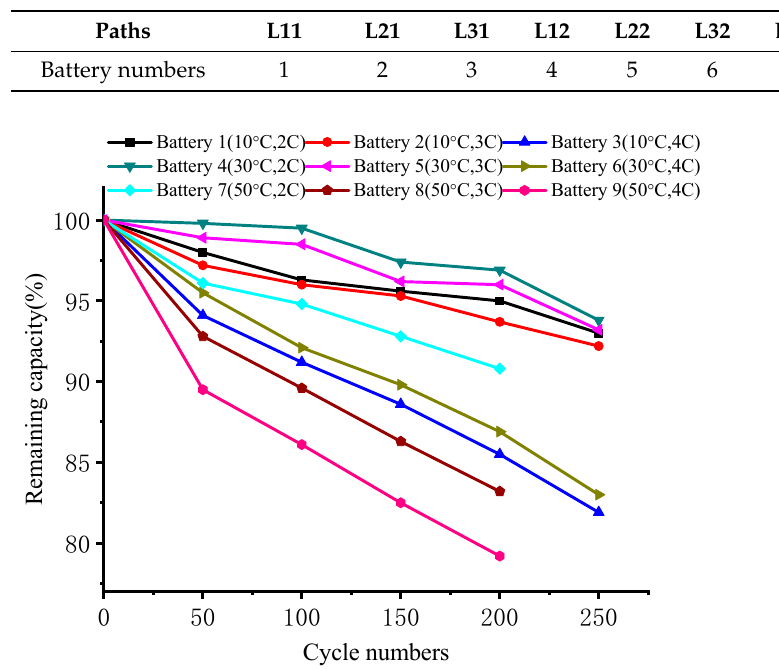
Table 3. Battery numbers and experimental conditions.